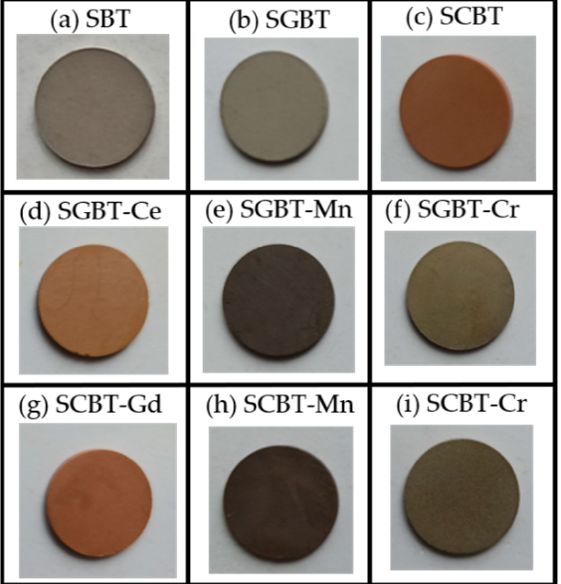
Figure 1. Appearances of the oxide-modified SBT ceramics (the corresponding chemical compositions (marked with ( a – i ) respectively) are located above the samples).